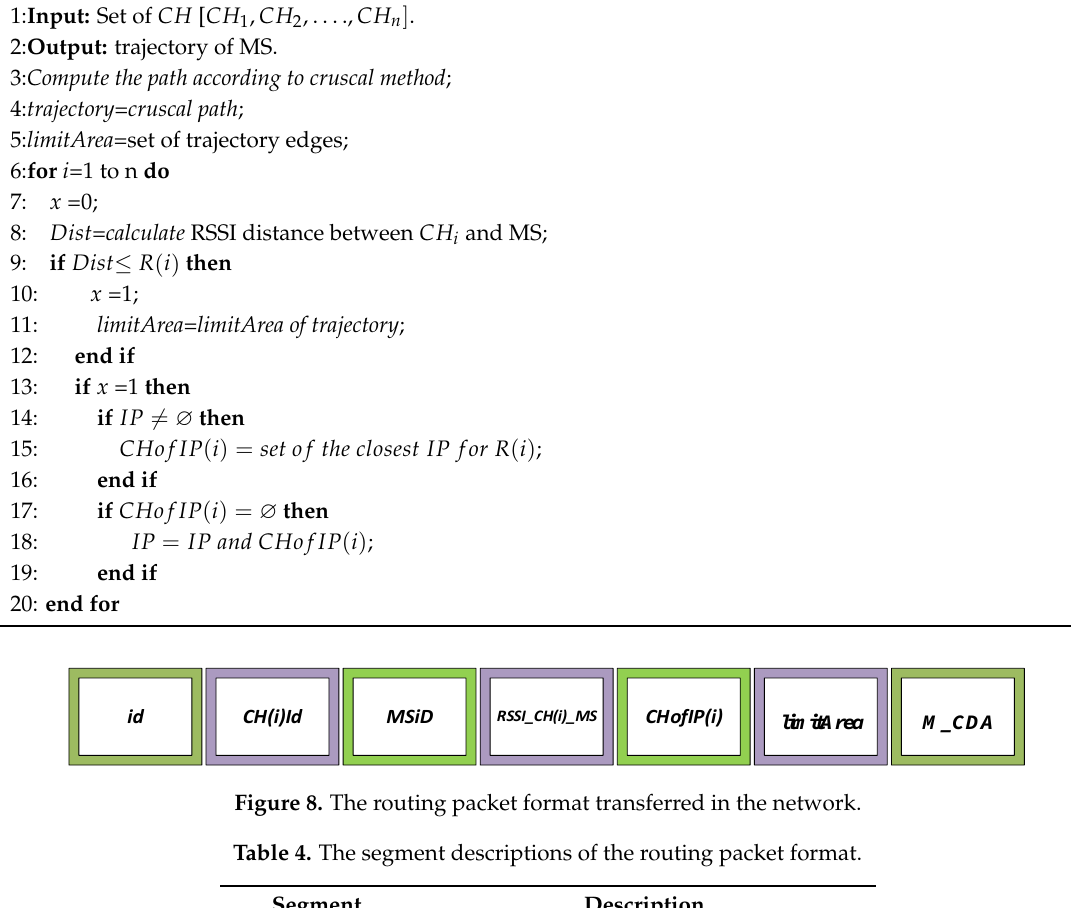
Figure 7. A sample of Mobile Sink (MS) trajectory.